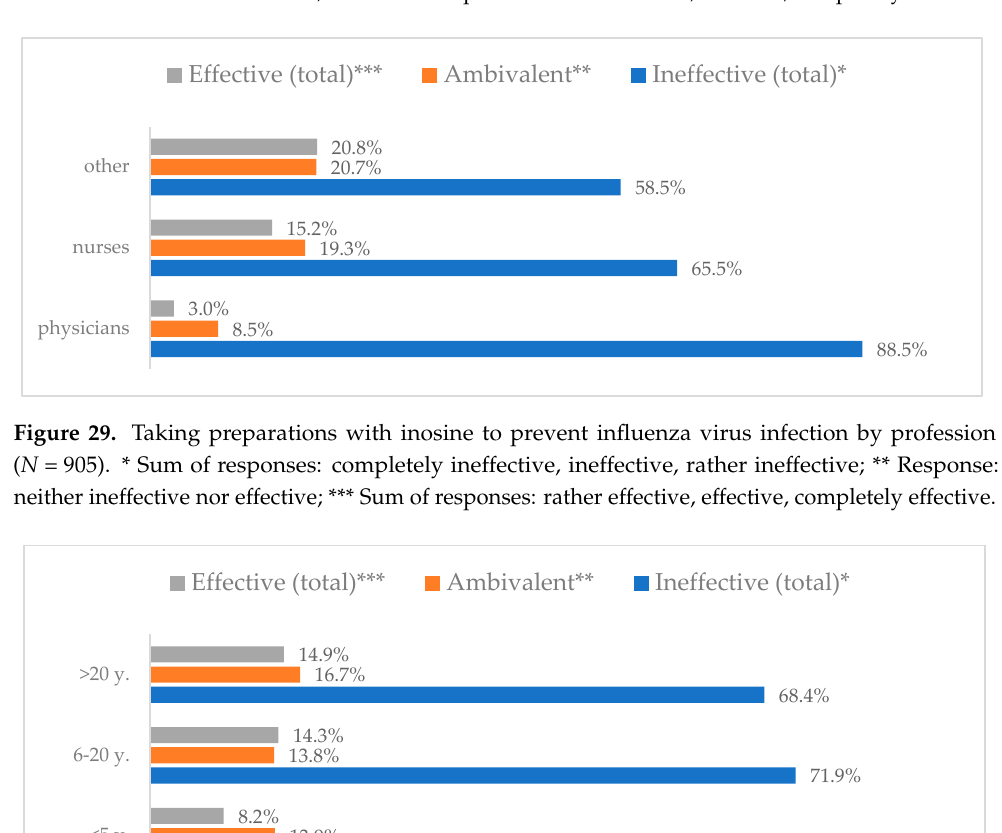
Figure 28. Taking preparations with inosine to prevent influenza virus infection by type of hospital ( N = 905). *Sum of responses: completely ineffective, ineffective, rather ineffective; **Response: neither ineffective nor effective; ***Sum of responses: rather effective, effective, completely effective.